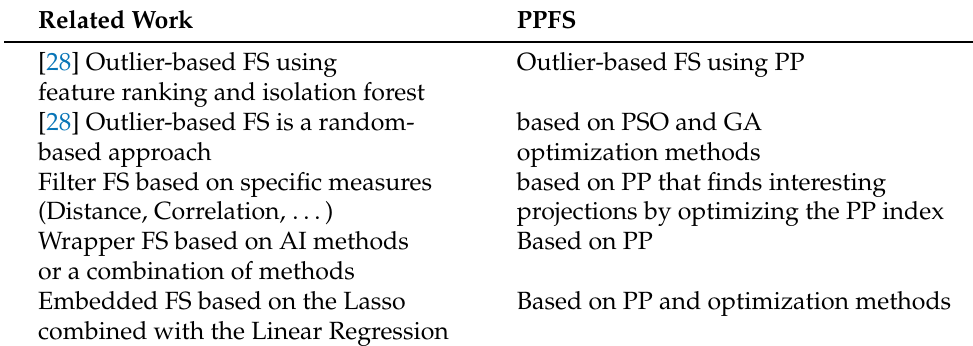
Table 1. Difference between the existing studies and the proposed